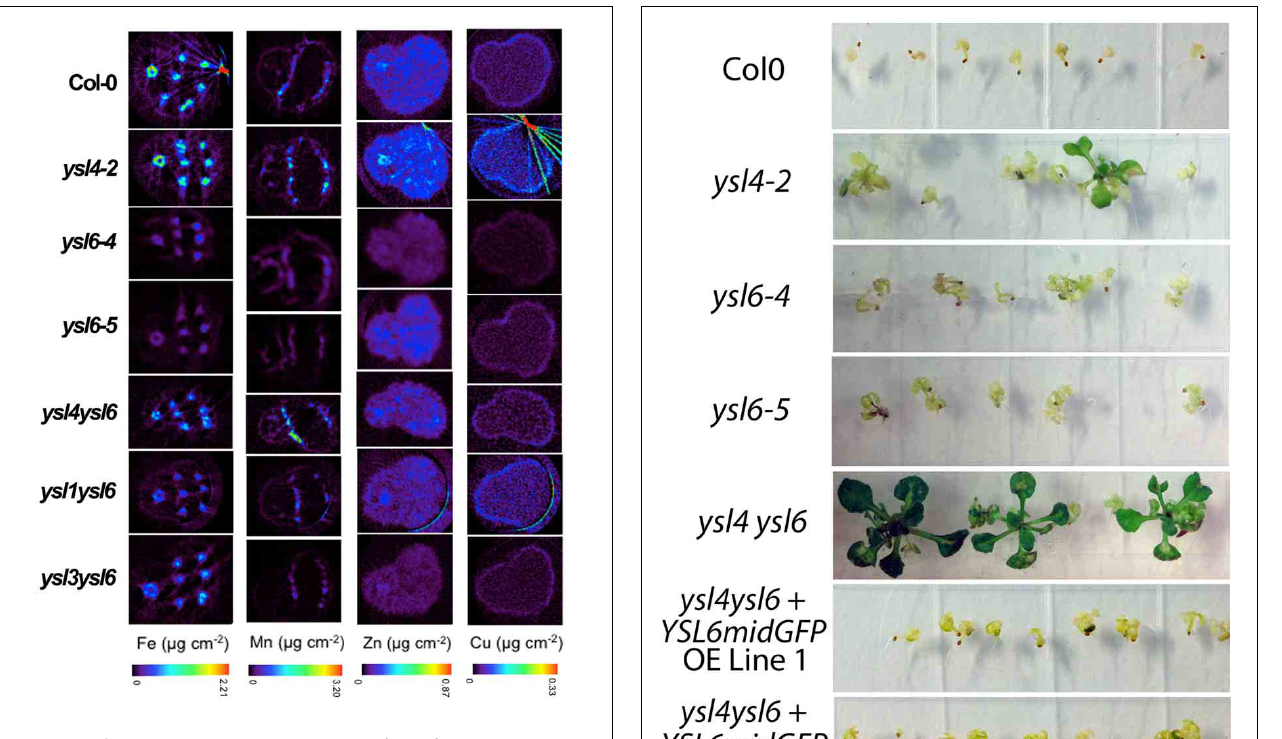
FIGURE 10 | Synchrotron X-ray Fluorescence (SXRF) Computed Microtomography showing the distribution of Fe, Mn, Zn, and Cu in Col-0 and ysl mutant lines. Tomograms (virtual cross sections) were collected via SXRF computed microtomographyfrom intact, dry Arabidopsis seed. All seeds are oriented with the radicle at left and cotyledons at right.